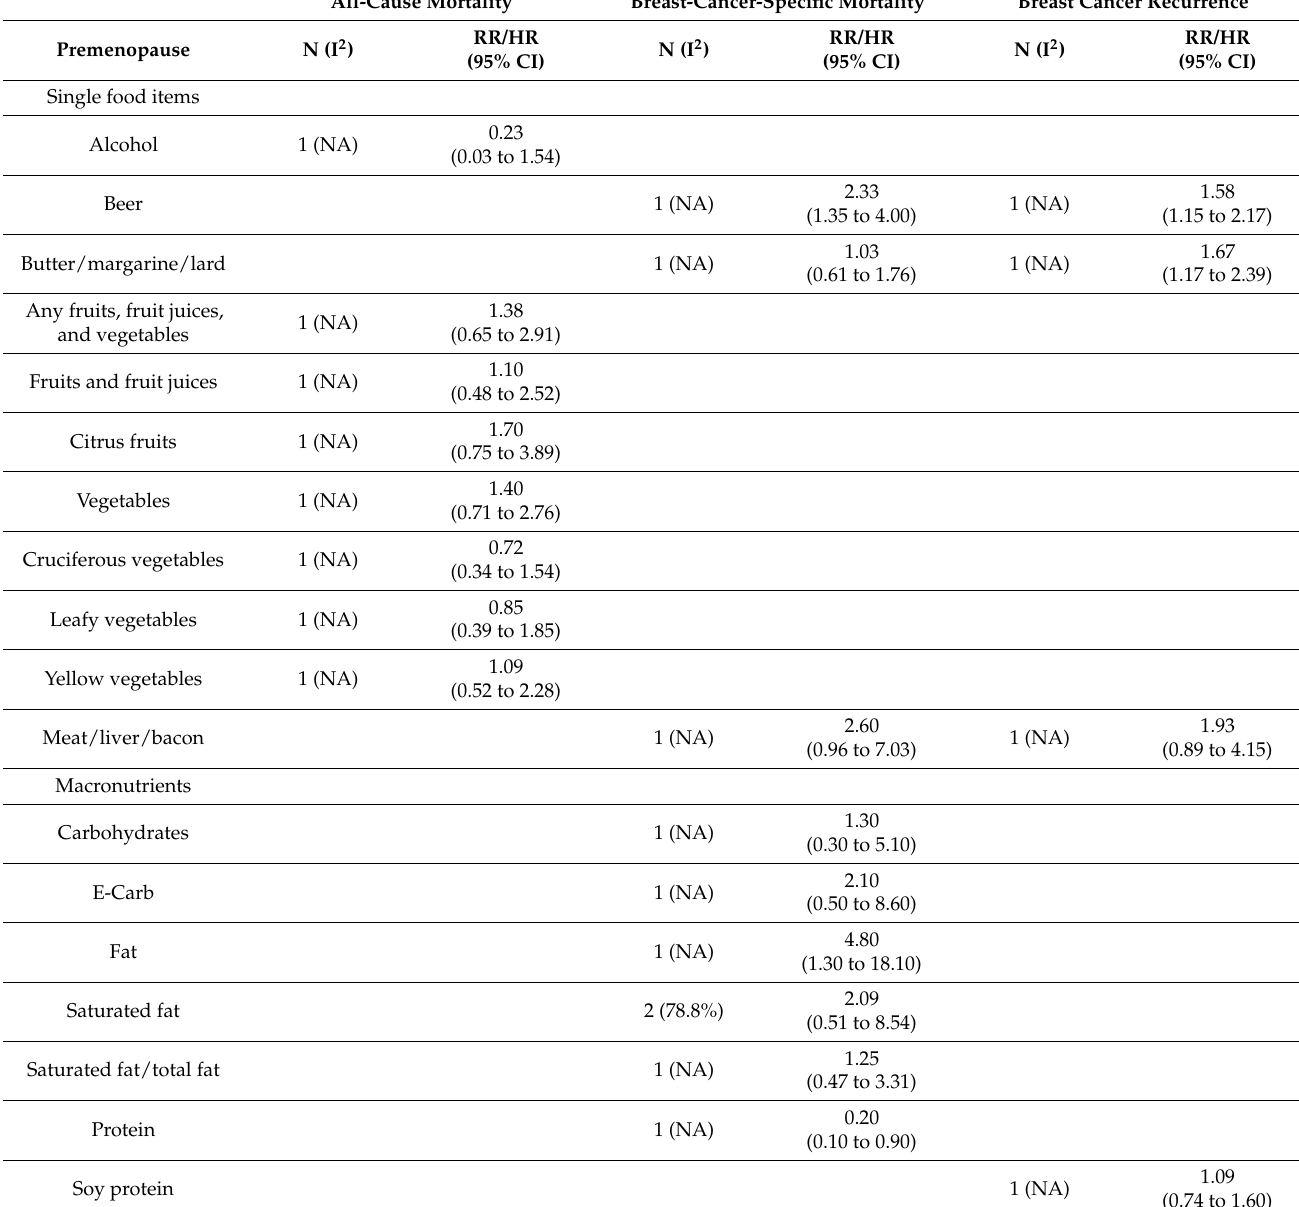
Table 2. Systematic review and meta-analysis of associations between dietary factors and breast cancer prognosis among breast cancer survivors by menopausal